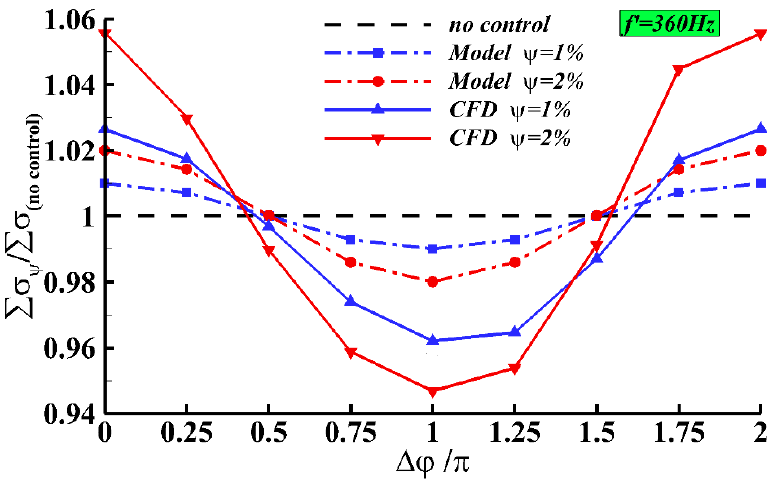
Figure 16. Control effects of mathematical model and computational fluid dynamics (CFD) simulation under different phases, and amplitudes.